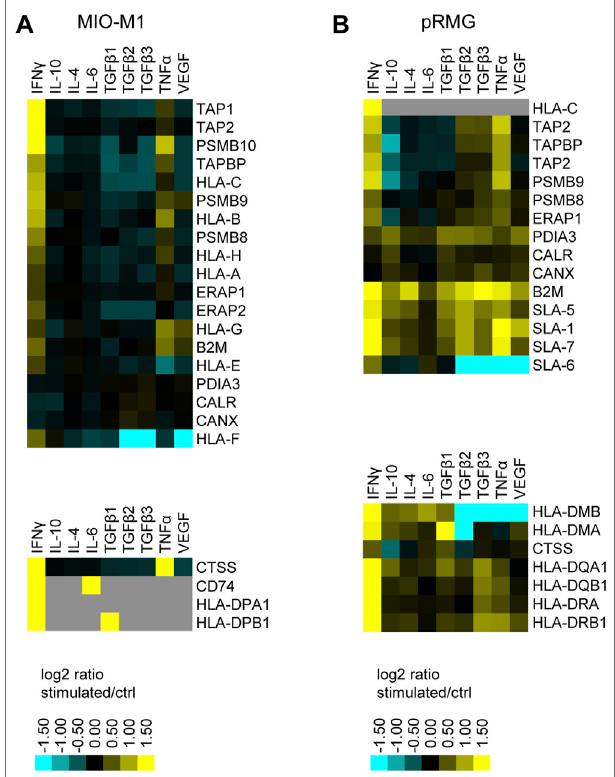
FIGURE 6 | Heatmap of hierarchical cluster analysis of proteins involved in MHC class I (upper panel) and MHC class II (lower panel) antigen presentation expressed by MIO-M1 cells (A) and pRMG cells (B) after treatment with various cytokines separately. Down-regulated proteins are presented in cyan, while up-regulated proteins are depicted yellow for the respective treatments. Gray squares represent proteins that were neither identi fi ed in the untreated control, nor in the respective treatment. The heatmap wasgenerated onthe basis ofthe log2 fold changeof therespective